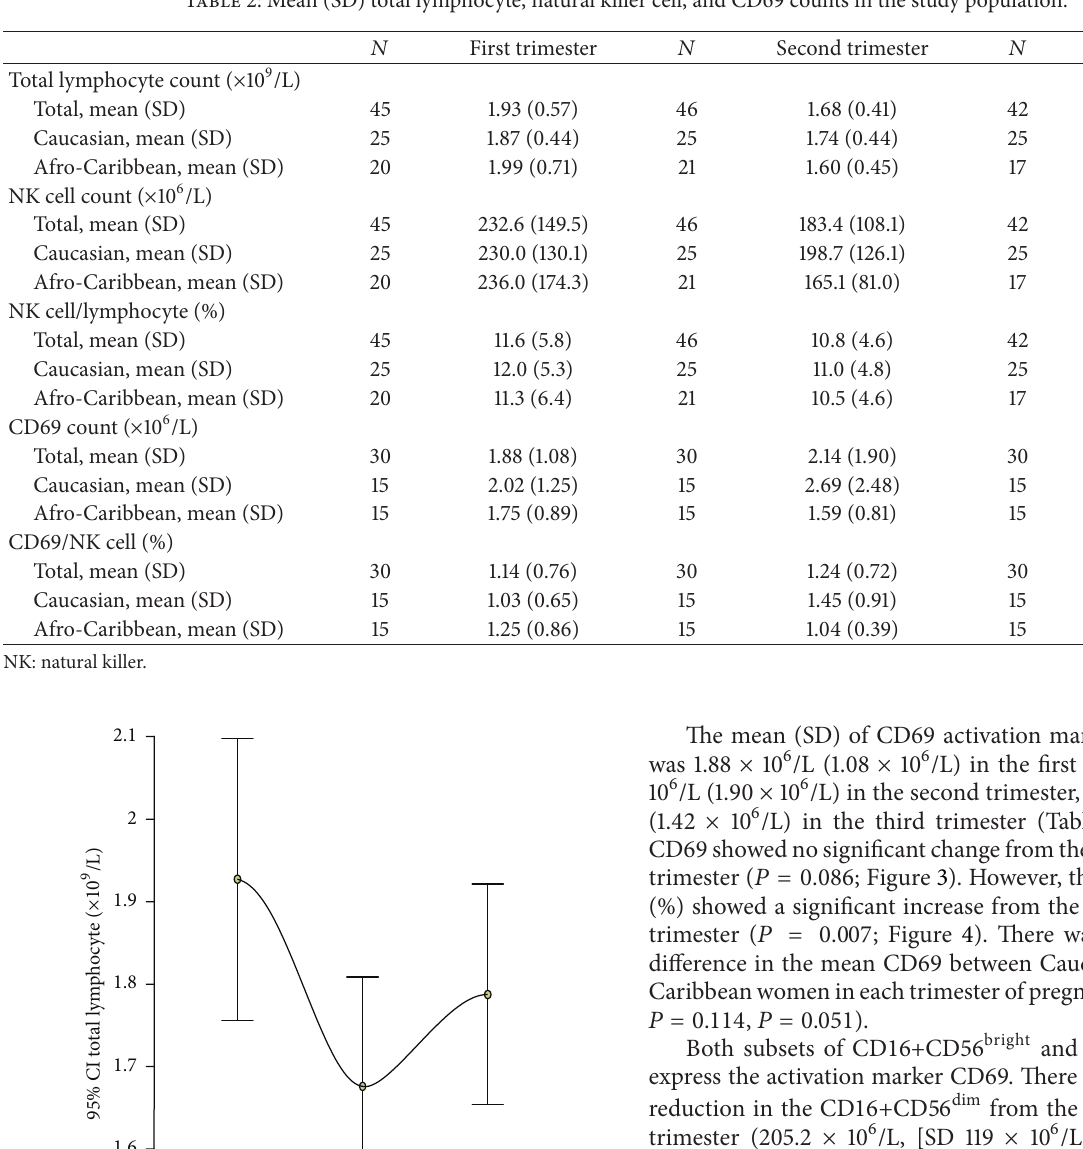
Table 2: Mean (SD) total lymphocyte, natural killer cell, and CD69 counts in the study population.